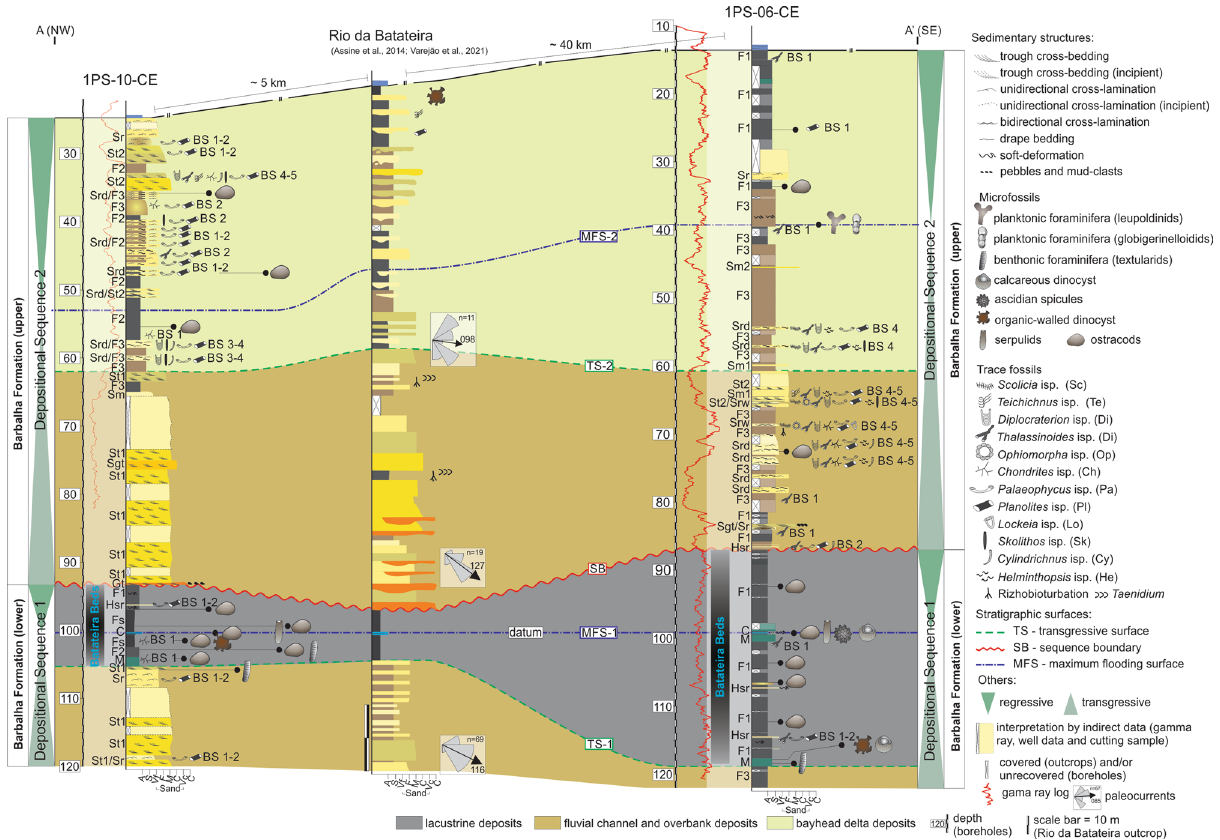
Figure 3. NW–SE stratigraphic section (location in Fig. 1b). Rio da Batateira sedimentary section adapted from Assine et al. 8 and Varejão et al. 34 . Graphic art made with CorelDRAW Graphics Suite × 6 version, 16.0 (https:// www. corel draw.